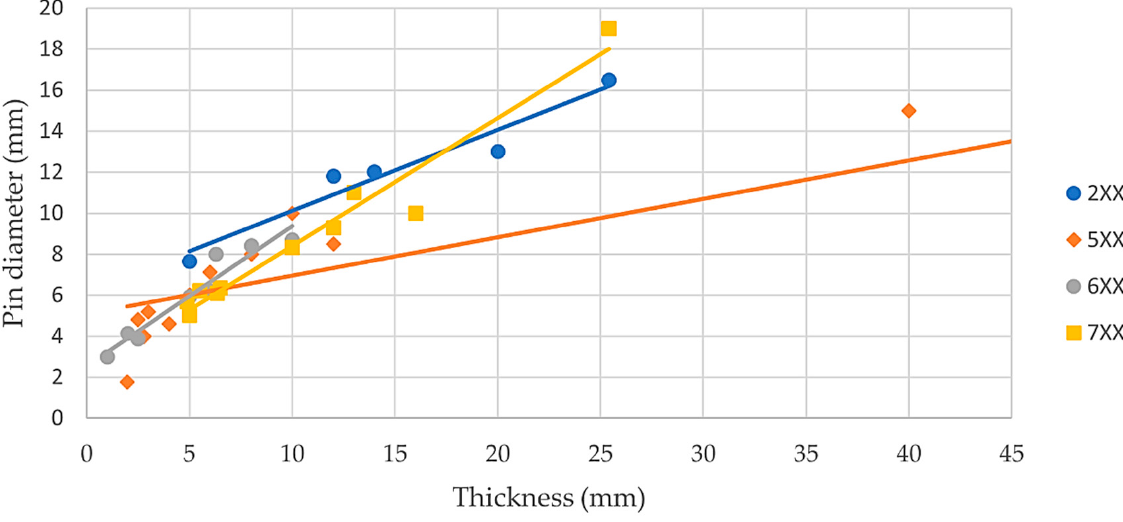
( d ) Figure 5. Pin length vs. thickness for series: ( a ) 2XXX; ( b ) 5XXX; ( c ) 6XXX; and ( d ) 7XXX.